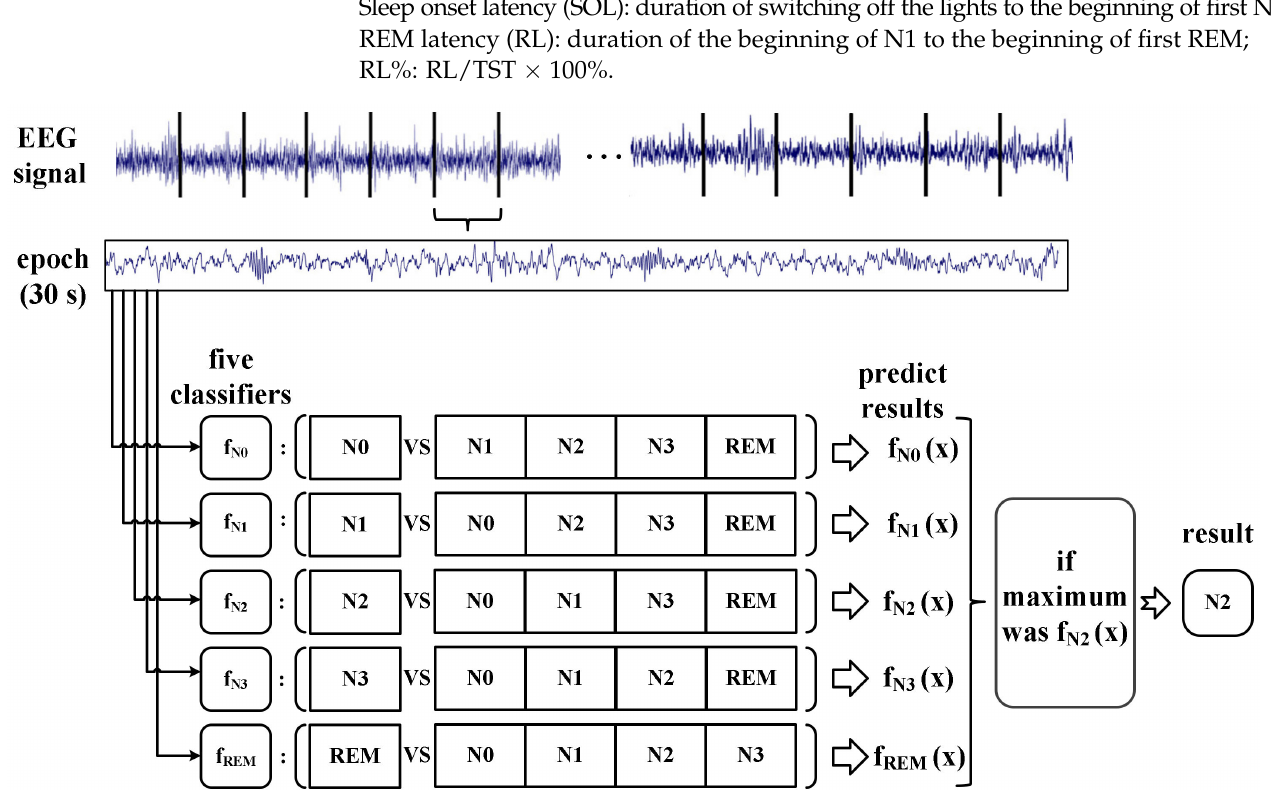
Figure 4. Schematic diagram of OvR. The diagram shows an example where the input epoch is classified as N2. X represents an EEG signal in an